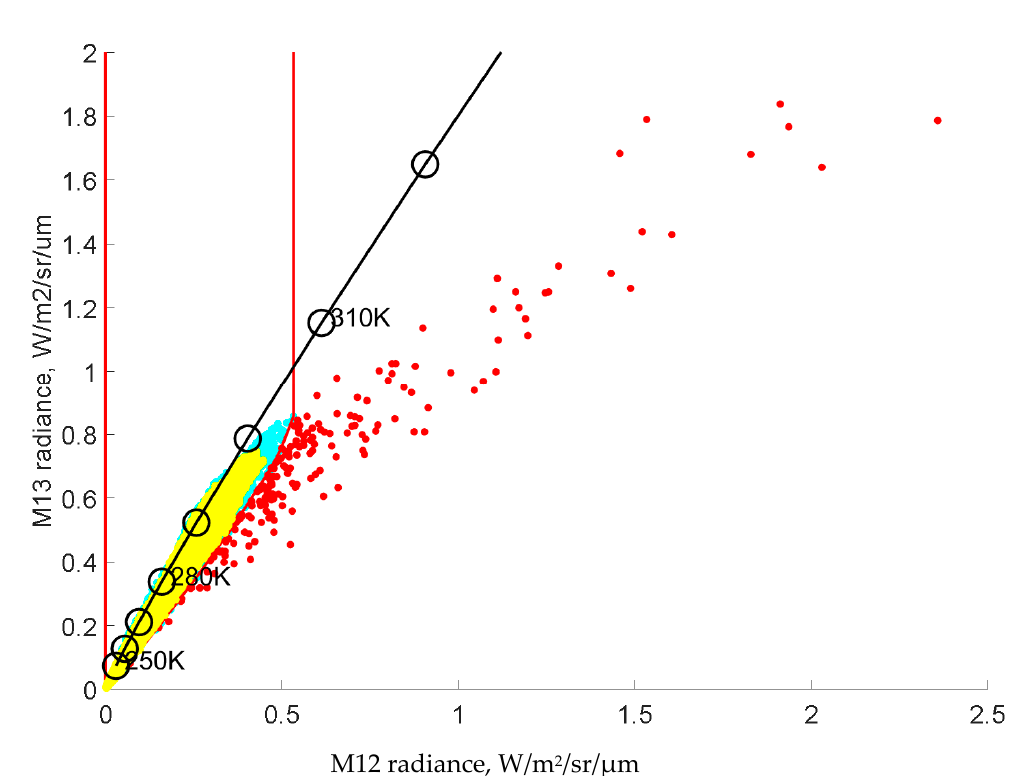
Figure 6. Scatterplot of observed radiances in VIIRS bands M12 and M13 for the satellite image with gas flares in the Near East. Full pixel background in shown in yellow, heat source outliers are shown in red. More details in the text.